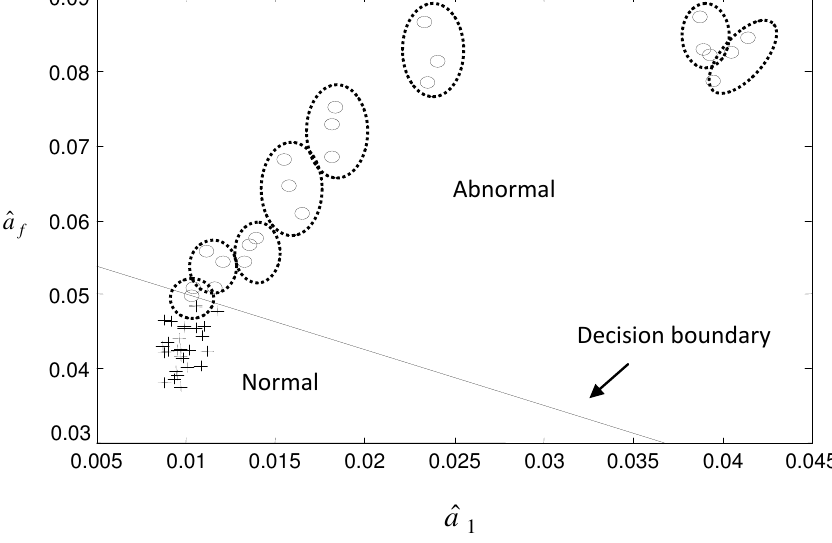
, â ) into regions f 1